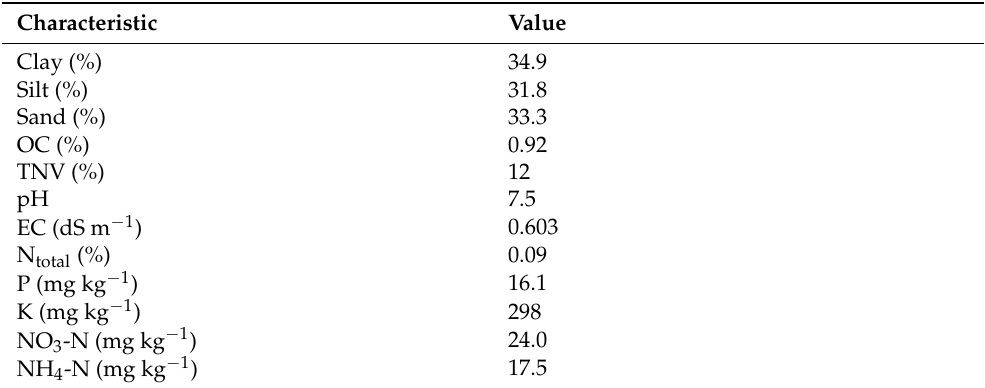
Table 2. Soil characteristics of the experimental